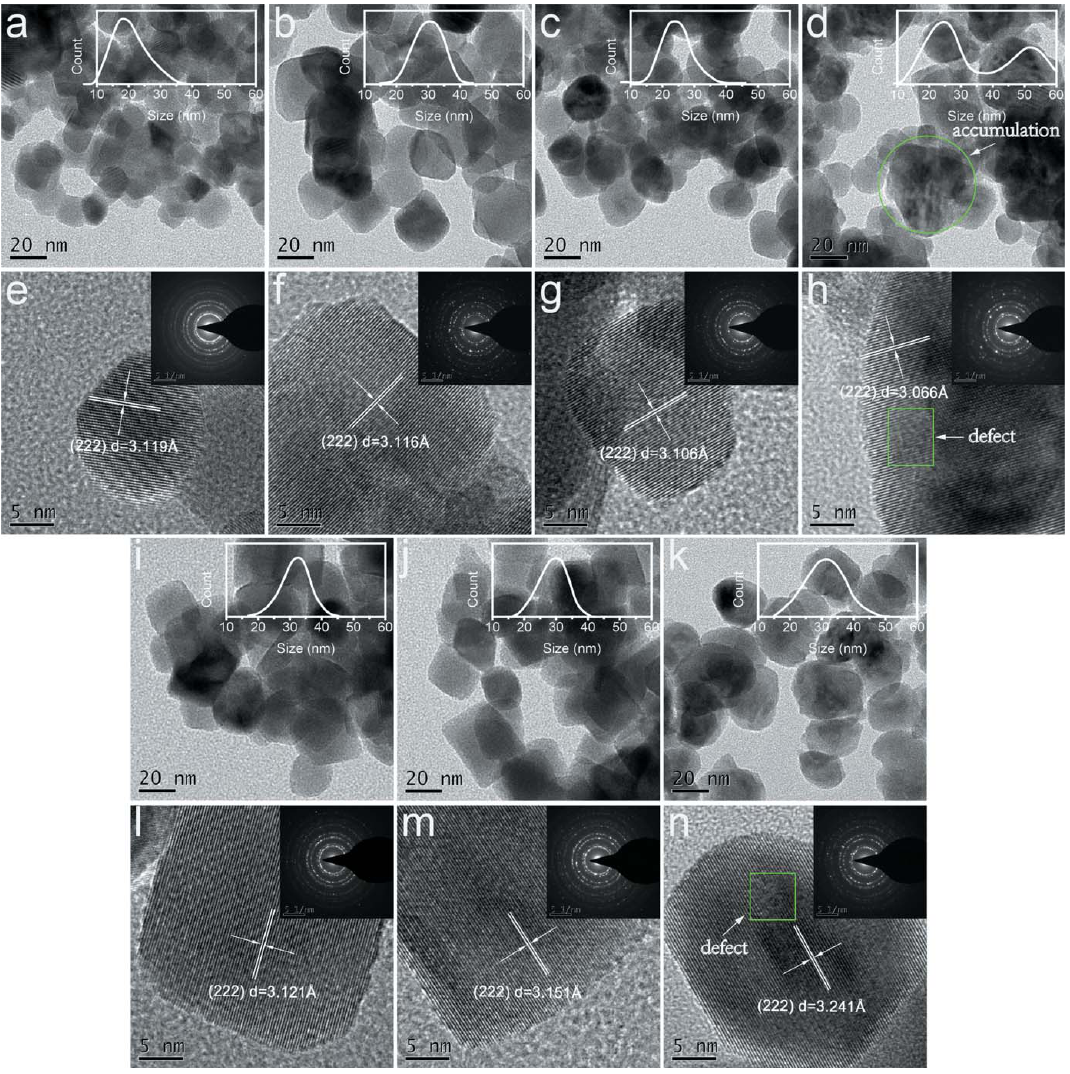
Figure 2 TEM images and HR-TEM results of U-doped NZO samples. Panels ( a , e ) refer to the NZO samples; ( b , f ), ( c , g ), ( d , h ) refer to the A (cid:5) 0.1, A (cid:5) 0.2 and A (cid:5) 0.4 samples, respectively; and ( i , l ), ( j , m ) and ( k , n ) refer to the B (cid:5) 0.1, B (cid:5) 0.2 and B (cid:5) 0.4 samples, respectively; additionally, the illustration shows the corresponding SAED